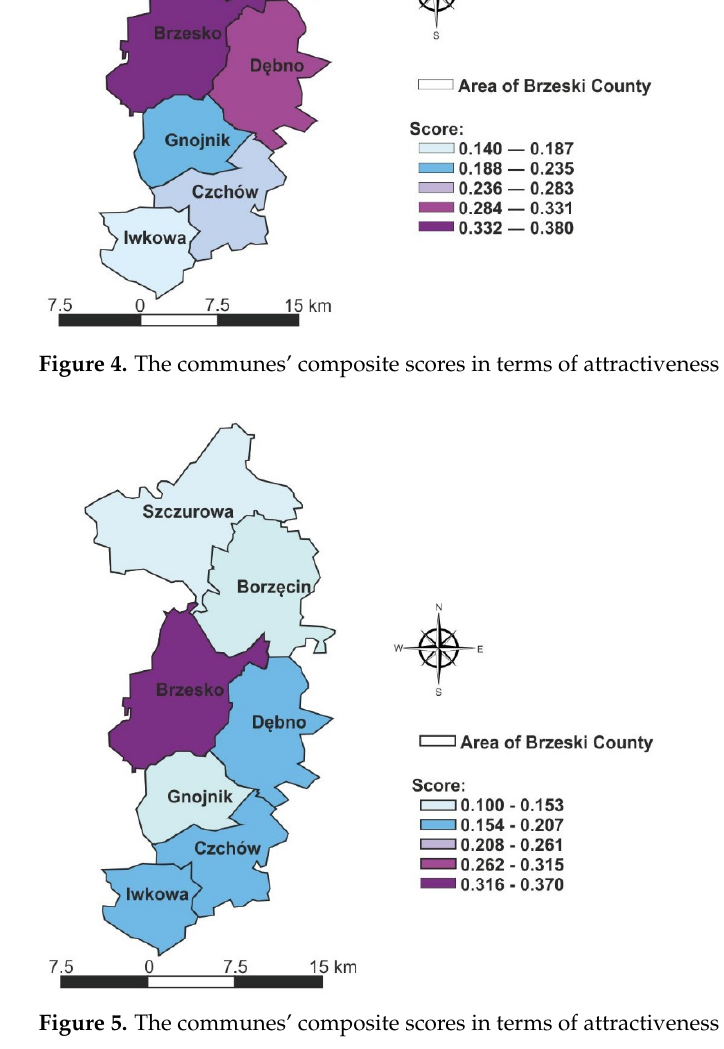
Figure 5. The communes’ composite scores in terms of attractiveness for investors.